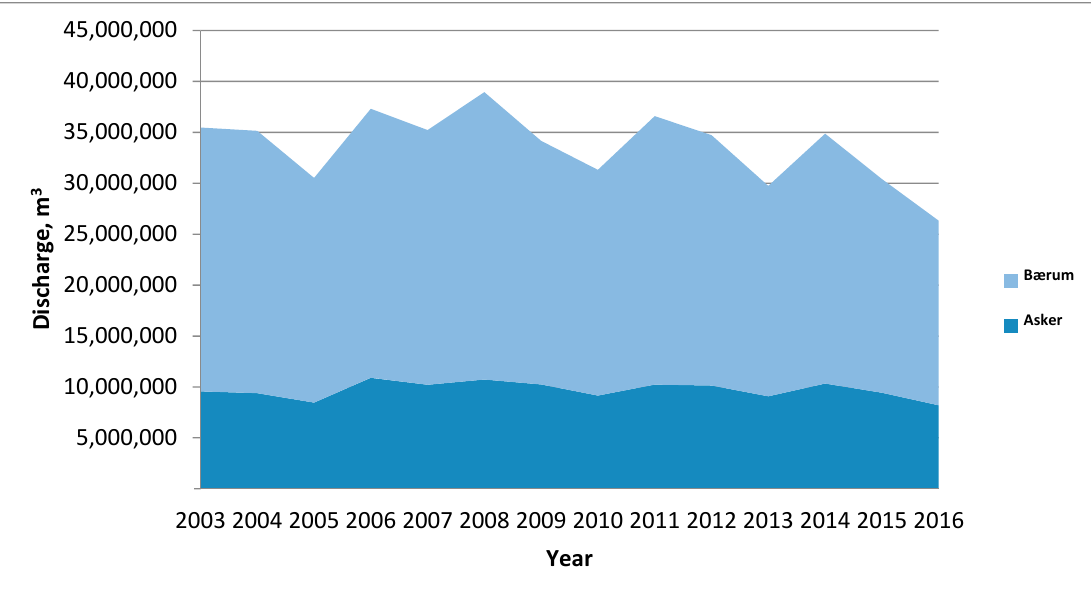
Figure 2. Wastewater from Asker and Bærum delivered to VEAS for the years 2003–2016. The water balance method has been used to calculate I/I-water in Asker and Bærum municipalities. The results of the calculations are shown in Table 6. Table 6. Calculated volumes of I/I-water in Asker and Bærum for 2008 and 2016. Input